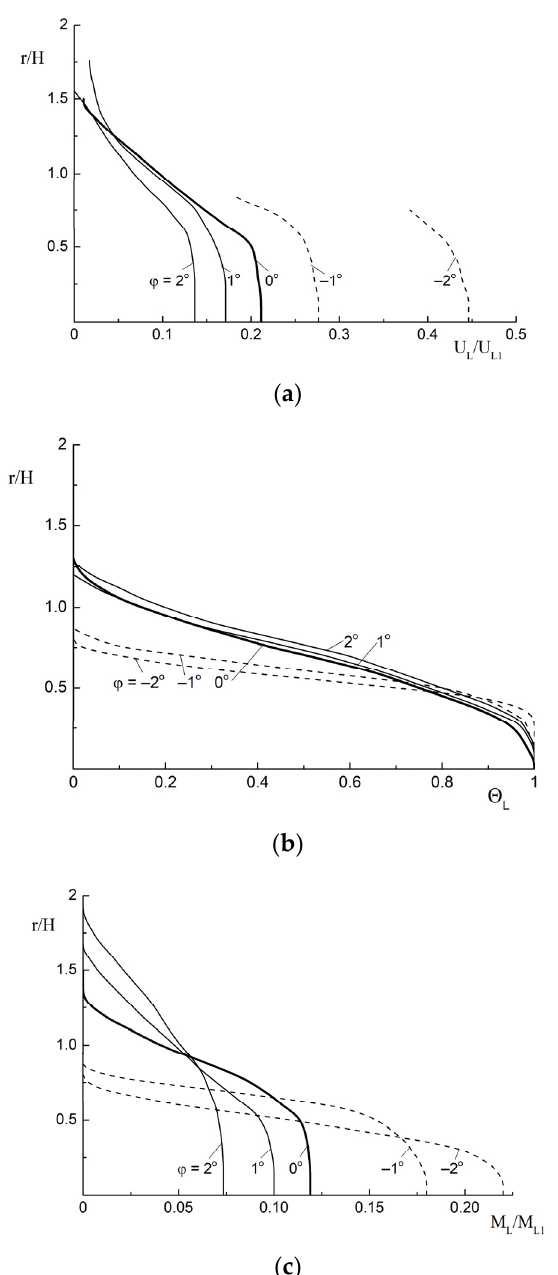
Figure 5. Mean axial velocity componet ( a ), temperature ( b ), and mass fraction ( c ) of the dispersed phase. The results for confuser (FPG, φ < 0°) are the dashed lines, for the diffuser (APG, φ > 0 0 ) are the solid curves, and the separated flow with φ = 0° are the bold lines. M L 1 = 0.05, d 1 = 30 μ m.